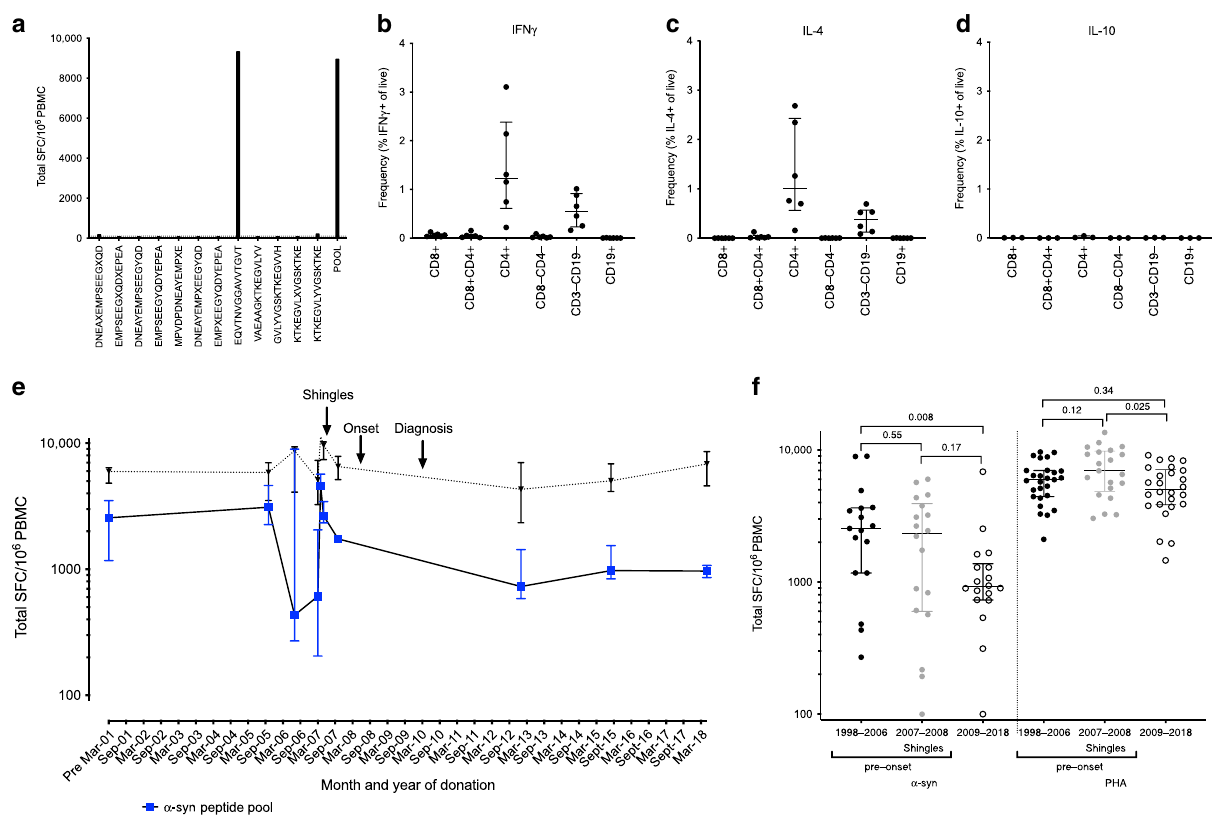
Fig. 1 α -Syn-speci fi c T cell responses in a longitudinal case study of PD. a Total magnitude of response expressed as total SFC (sum of IFN γ , IL-5, and IL-10 responses) per 10 6 cultured PBMC against a pool of α -syn peptides (furthest to the right) and all individual α -syn peptides included in the pool. Representative data from PBMC collected in 2006. b – d After eliminating non-lymphocytes and doublet cells by forward and side-scatter, and dead cells by Live/Dead stain, CD3 + T cells were gated based on their CD4 and CD8 expression (CD8 + , CD8 + CD4 + , CD4 + , CD8 − CD4 − ), and other populations as indicated; CD3 − CD19 − and CD19 + (Supplementary Fig. 5), percentage cytokine of live cells from each of these were plotted. b IFN γ ( n = 6), c IL-4 ( n = 6), and d IL-10 ( n = 3). Each point represents a sample collected between 1998 and 2015 (1998, 2005, 2006, 2007, 2013, and 2015); median± interquartile range is indicated. e Total magnitude of response expressed as total SFC (sum of IFN γ , IL-5, and IL-10 responses) per 10 6 cultured PBMC against a pool of α -syn peptides or PHA. The time period spans 1998 (pre-2001) to 2018. Median ± interquartile range is indicative of individual experimental replicates. Pre- March-01 n = 10, Oct-05 n = 4, Jul-06 n = 3, Mar-07 n = 9, Apr-07 n = 3, May-07 n = 5, Oct-07 n = 1, Jan-13 n = 4, Aug-15 n = 12, and May-18 n = 2. f Total magnitude of response divided into pre- (1998 – 2006) ( n = 17) and (2007 – 2008) ( n = 18), which re fl ects the period this individual experienced shingles) and post- (2009 – 2018) ( n = 18) PD onset/diagnosis for α -syn-speci fi c responses (left) and PHA (right). Each point represents an individual independent experimental replicate; the median ± interquartile range is indicated. Two-tailed Mann – Whitney test. The data are displayed on a logarithmic